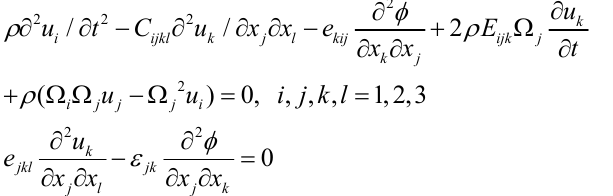
Figure 2. The dynamic equations of linear piezoelectricity with Coriolis and centrifugal